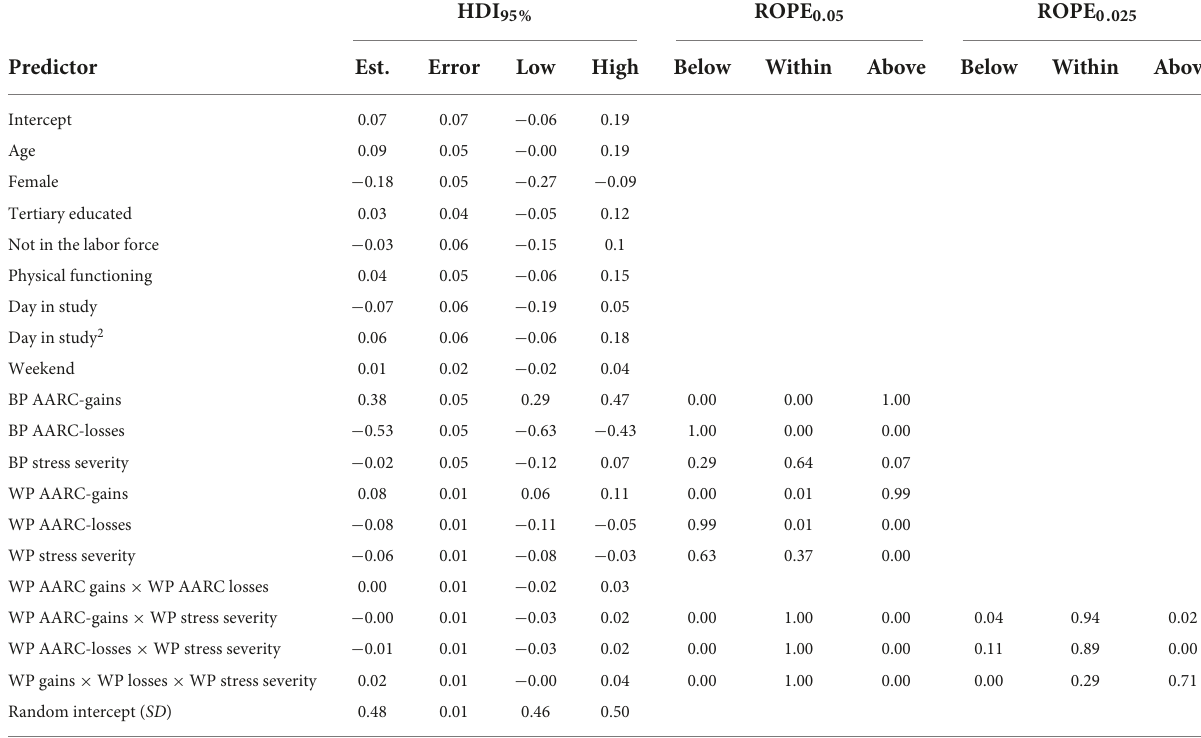
TABLE 3 Results of Bayesian hierarchical mixed model predicting vitality. HDI 95% ROPE 0 . 05 ROPE 0 . 025 Est. Low High Below Within Above Below Within